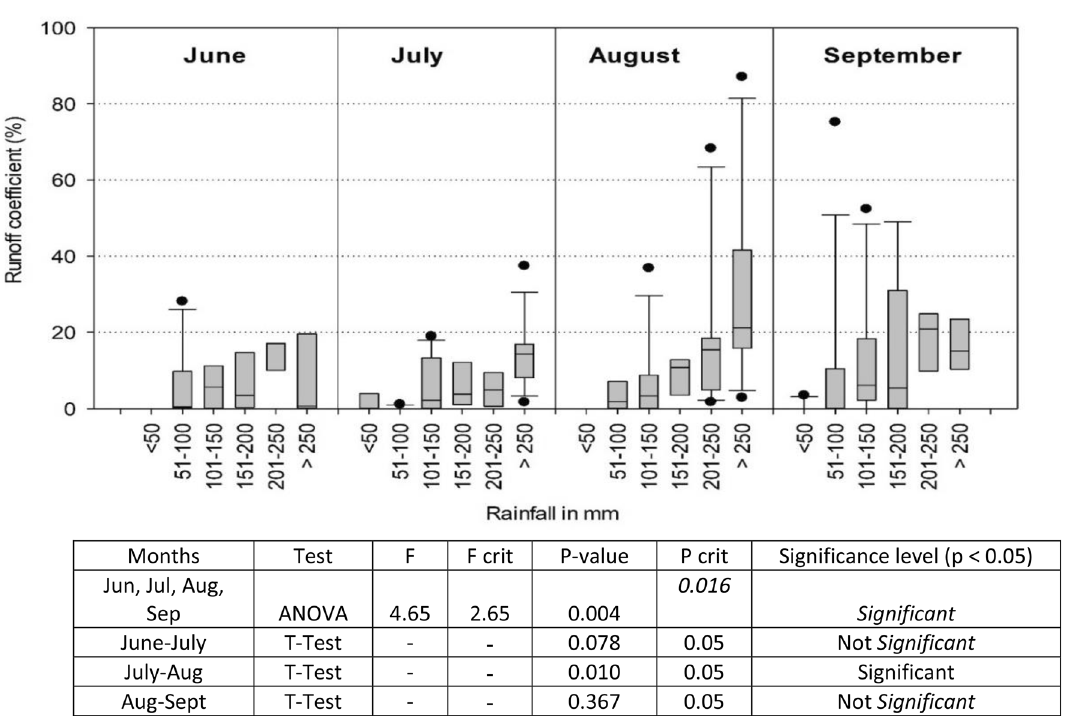
Figure 10. Runoff coefficients in different months with different amounts of rainfall every